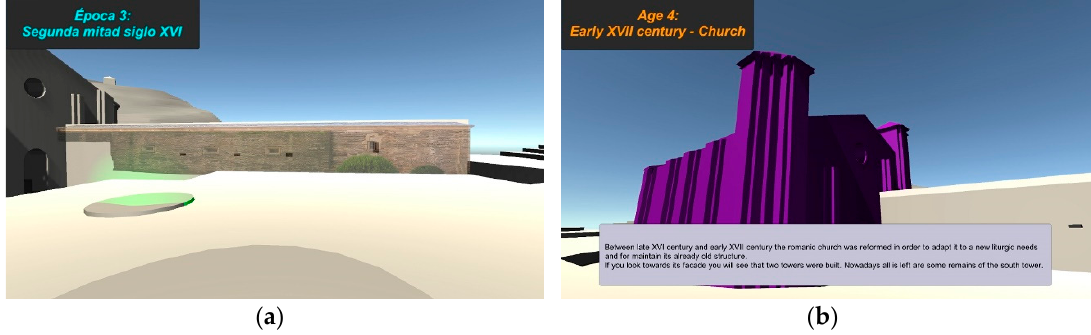
Figure 1. Screenshots of two interactive buttons designed: ( a ) to display graphic research sources, and ( b ) to give access to a brief textual and audio